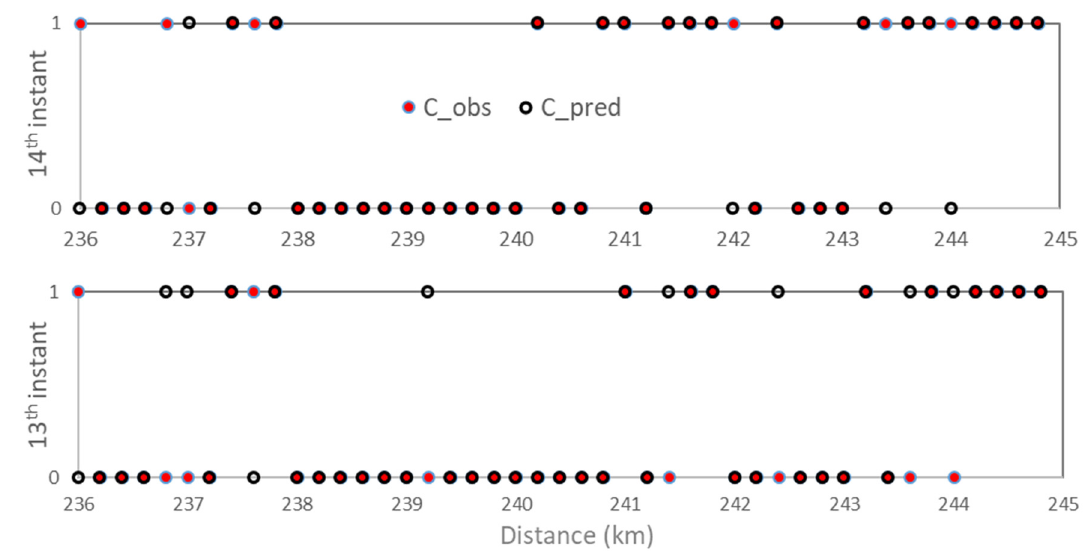
Figure 10. Model